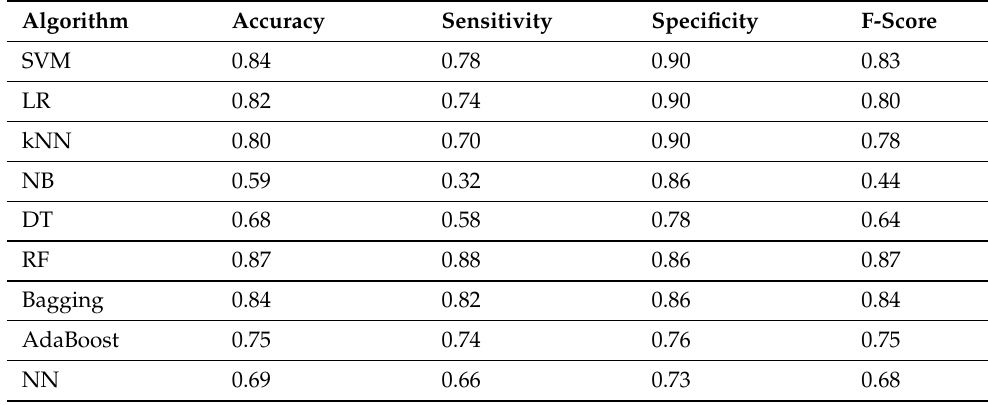
Table 2. Results with 80–20% train-test